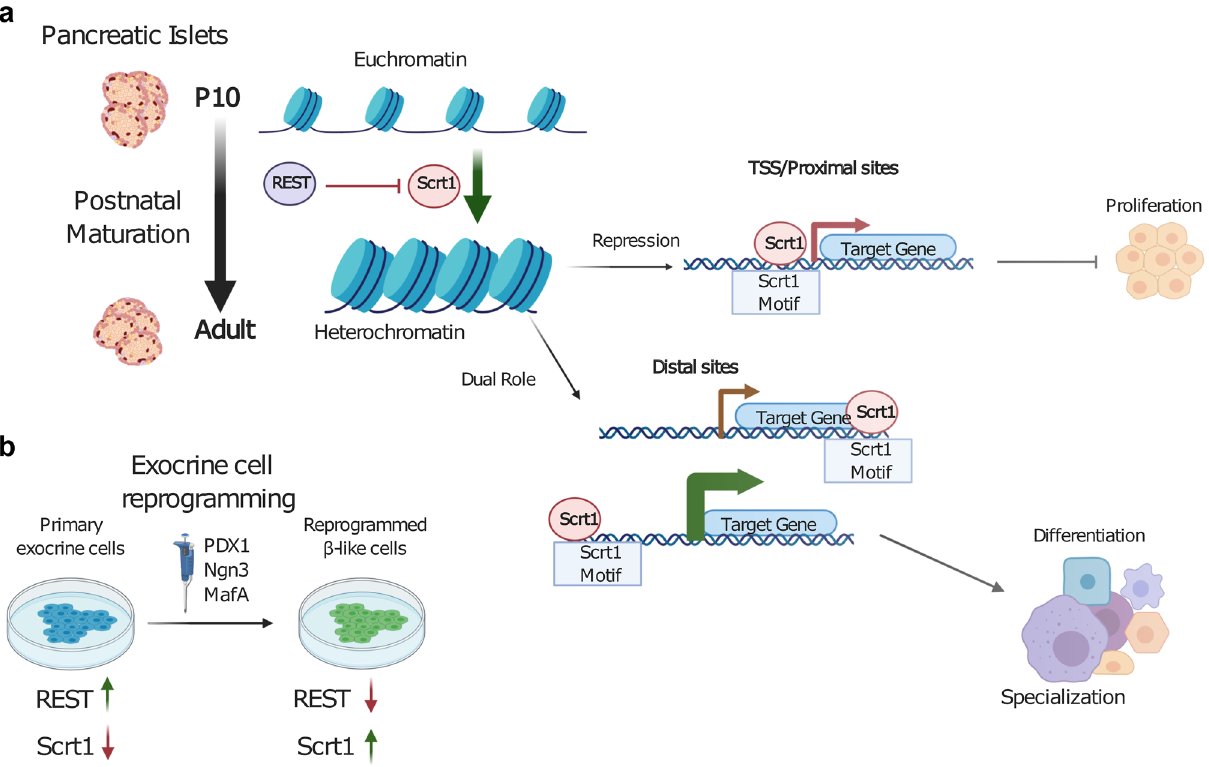
Figure 5. Summary figure: Chromatin accessibility along maturation is affected by Scrt1. In the present study we investigated the chromatin accessibility along the post-natal pancreatic islet maturation process. ( a ) SCRT1 motif is enriched in ACS that are closing upon maturation. We found that Scrt1 is a direct target of REST and that the Scrt1 motif is present in TSS/proximal sites as well as distal sites. The inhibition of Scrt1 lead to increased proliferation and has additional effects on other processes such as specialization. ( b ) In an in vitro reprogramming system, Scrt1 expression raises after PNM infection and is anti-correlated with REST